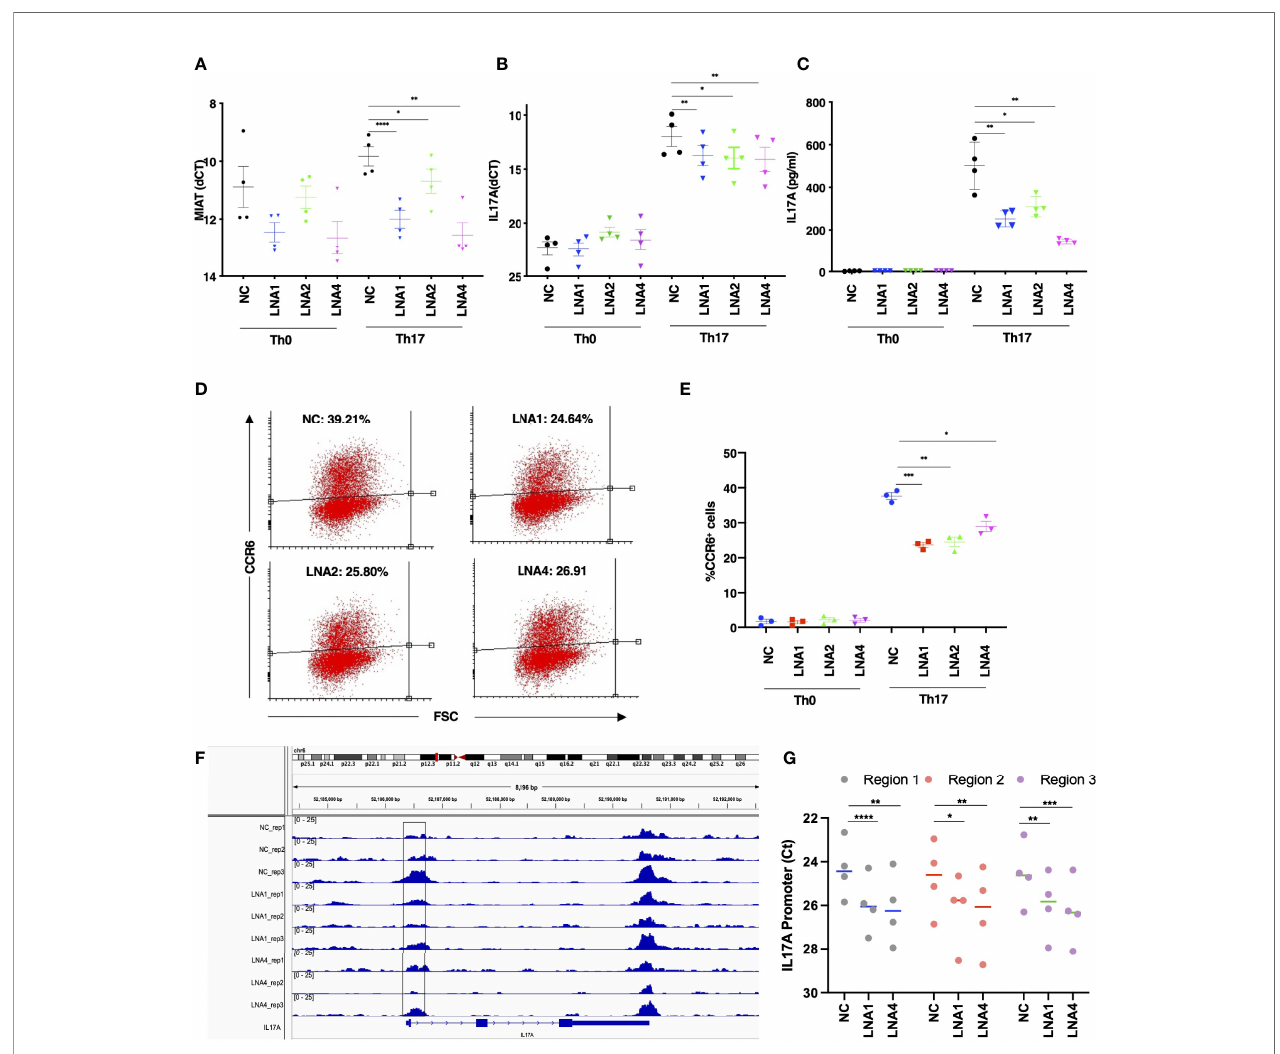
FIGURE 3 | MIAT Positively Regulates Human Th17 Cell Differentiation. (A) TaqMan qPCR analysis of MIAT-silenced Th0 and Th17 (72 h) cells. Three different LNAs (LNA1, LNA2, and LNA4), targeting different MIAT regions, were used to silence MIAT. NC represents non-targeting LNA used as a negative control. Each dot represents an independent experiment perfomed on T cells puri fi ed from umbilical cord blood samples collected from different individuals. Error bars represent SEM. Students ’ paired two-tailed t-test was used to determine the signi fi cance. *, p <0.05; **, p <0.01; ****, p <0.0001. (B, C) The TaqMan qPCR analysis of IL17A expression (B) and IL-17A secretion detected by Luminex assay (C) in MIAT silenced, 72 h polarized Th17, and Th0 cells. Students ’ paired two-tailed t-test was used to determine the signi fi cance. *, p <0.05; **, p <0.01. In panels A-C, the experiments were performed on four pools of CD4 + T cells, where each pool contained cells puri fi ed from umbilical cord blood collected from 3-5 individuals. (D, E) Flow cytometry analysis of CCR6 expression in MIAT-silenced control (Th0) and Th17 polarized cells (72 h). Panel (D) shows the scatter plots from one experiment, and (E) shows the data from all three experiments. The experiments were performed on three pools of CD4 + T cells, where each pool contained cells puri fi ed from umbilical cord blood collected from 3-5 individuals. Error bars represent SEM. Students ’ paired two-tailed t-test was used to determine the signi fi cance. *, p <0.05; **, p <0.01; ***, p <0.001. (F) Visualization of ATAC-seq data at IL17A locus. Data from three biological replicates are shown. The highlighted region was validated by ATAC-PCR. The experiments were performed on three pools of CD4 + T cells, where each pool contained cells puri fi ed from umbilical cord blood collected from 3-5 individuals. (G) ATAC-seq library was ampli fi ed using primers to detect the three subregions of the highlighted regions in panel (F) The experiments were performed on CD4 + T cells, from umbilical cord blood collected from 4 individuals. Statistical signi fi cance was determined using paired two tailed t-test. *, p <0.05; **, p <0.01; ***, p <0.001,